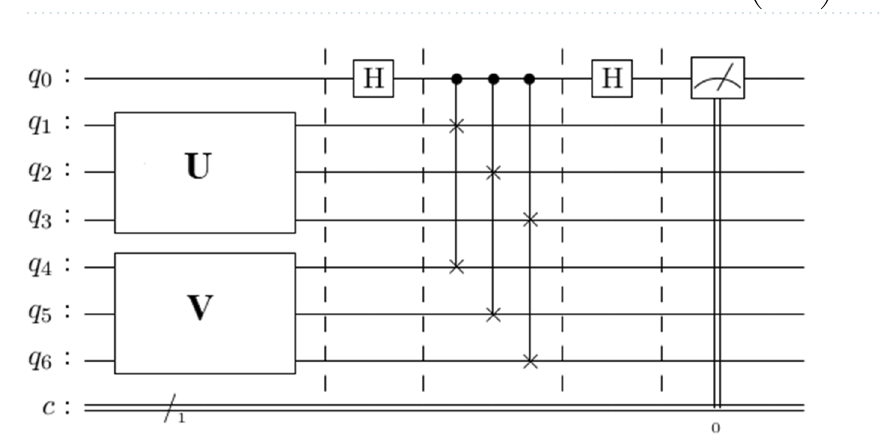
Figure 2. Quantum circuit computes the real part of the inner product ancilla qubit ( q 0 ) into uniform superposition. A single-controlled unitary gate entangles the exited state of the ancilla qubit with the training data state vector ( single unitary controlled gate entangles the state vector of the test data ( of the ancilla qubit. A second X gate flips the ancilla qubit. The Hadamard gate on the ancilla qubit interferences train and test data state vectors. The ancilla qubit is measured using a Pauli- Z gate. The real value of estimated from Eq. (9). The measurement gate is done by a Pauli- Z gate and Z